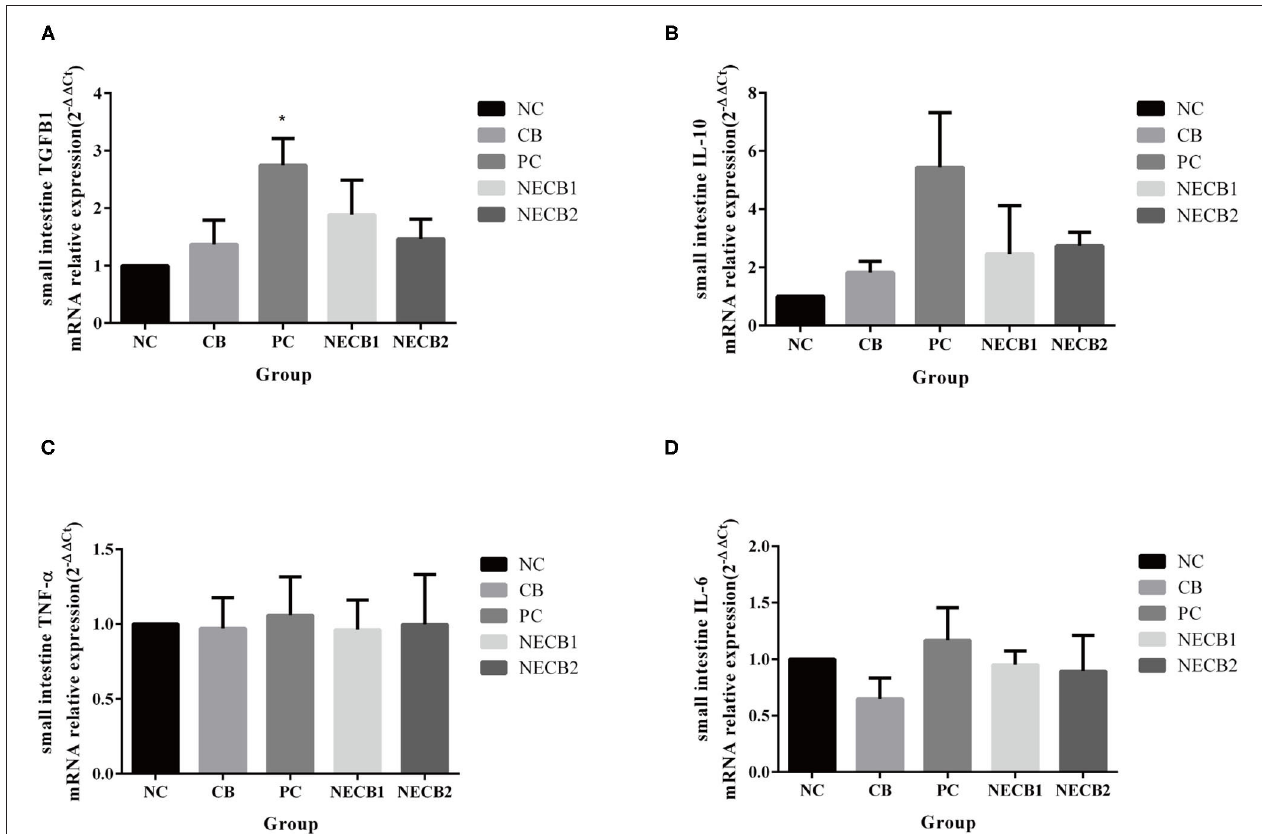
FIGURE 6 | Effect of diet C. butyricum on the expression of cytokines related-genes in the small intestine of broilers infected with NE. (A) TGFB1. (B) IL-10. (C) TNF- α . (D) IL-6. Each result represents the mean ± SEM ( n = 3). *Represent p < 0.05.